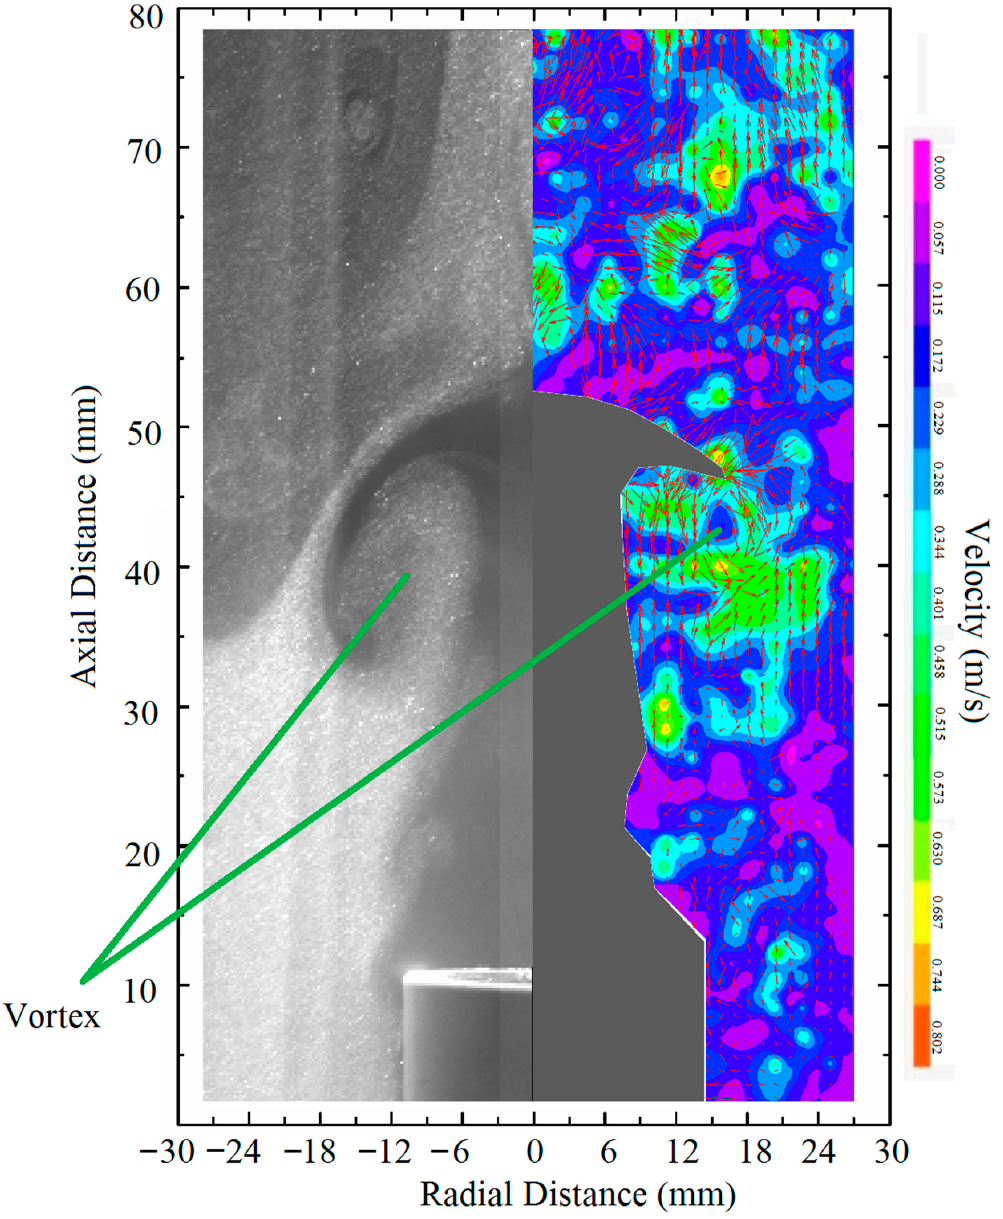
Figure 8. Vortex structure in partially premixed flame under acoustic excitation.